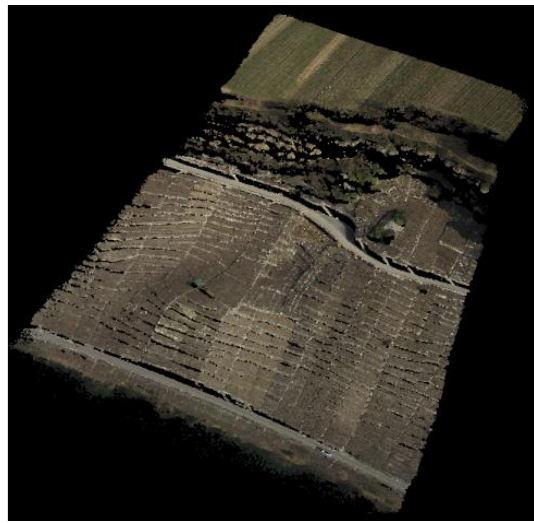
Figure 8: Point cloud generated for single match image.